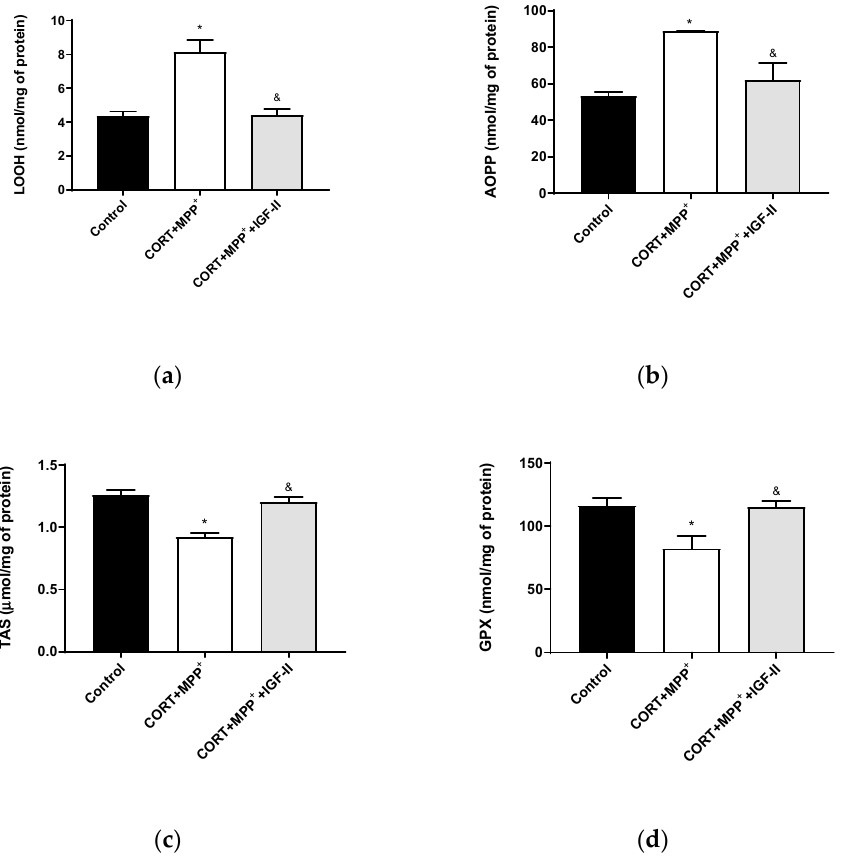
Figure 2. Oxidative chemistry biomarkers and antioxidant enzyme activity in SN4741 neuronal cells after 6 h of incubation with the combination of corticosterone and MPP + (CORT + MPP + ) in the presence or absence of IGF-II. ( a ) Levels of lipid hydroperoxides, LOOH; ( b ) levels of advanced-oxidation protein products, AOPP; ( c ) levels of total antioxidant status, TAS; ( d ) activity of glutathione peroxidase, GPX. Data from four to six independent experiments were combined and presented as mean ± SEM. * p < 0.05 compared to control cells; & p < 0.05 compared to CORT + MPP + co- incubated